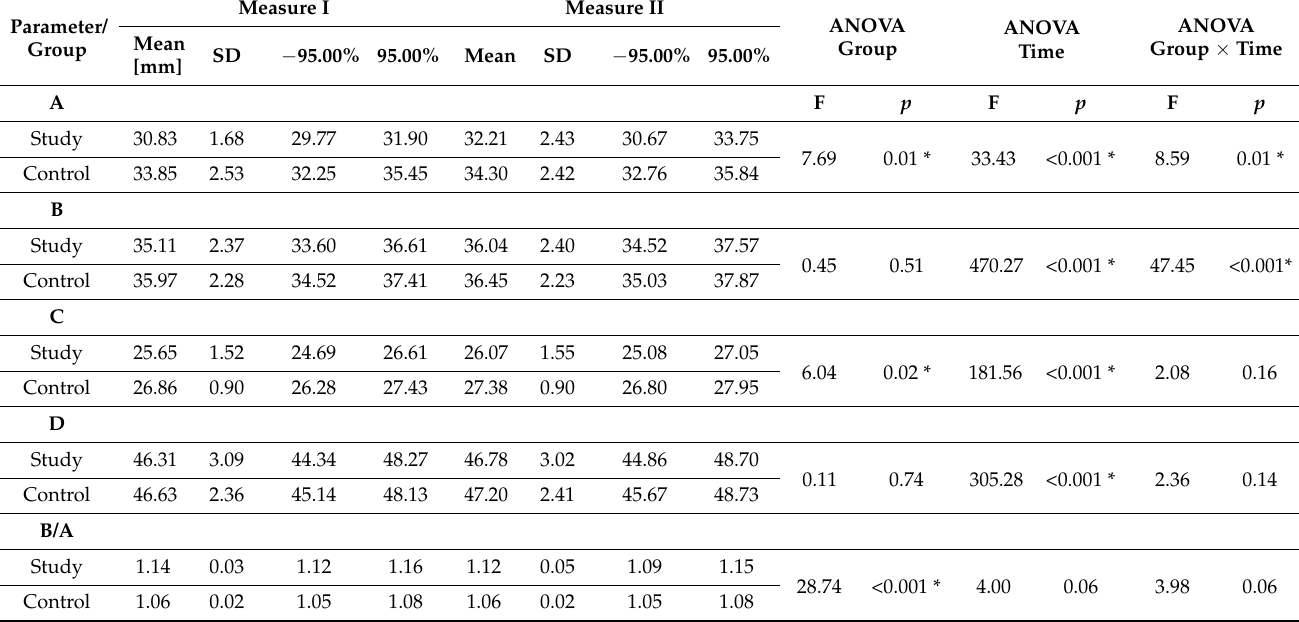
Table 3. Results of the ANOVA.